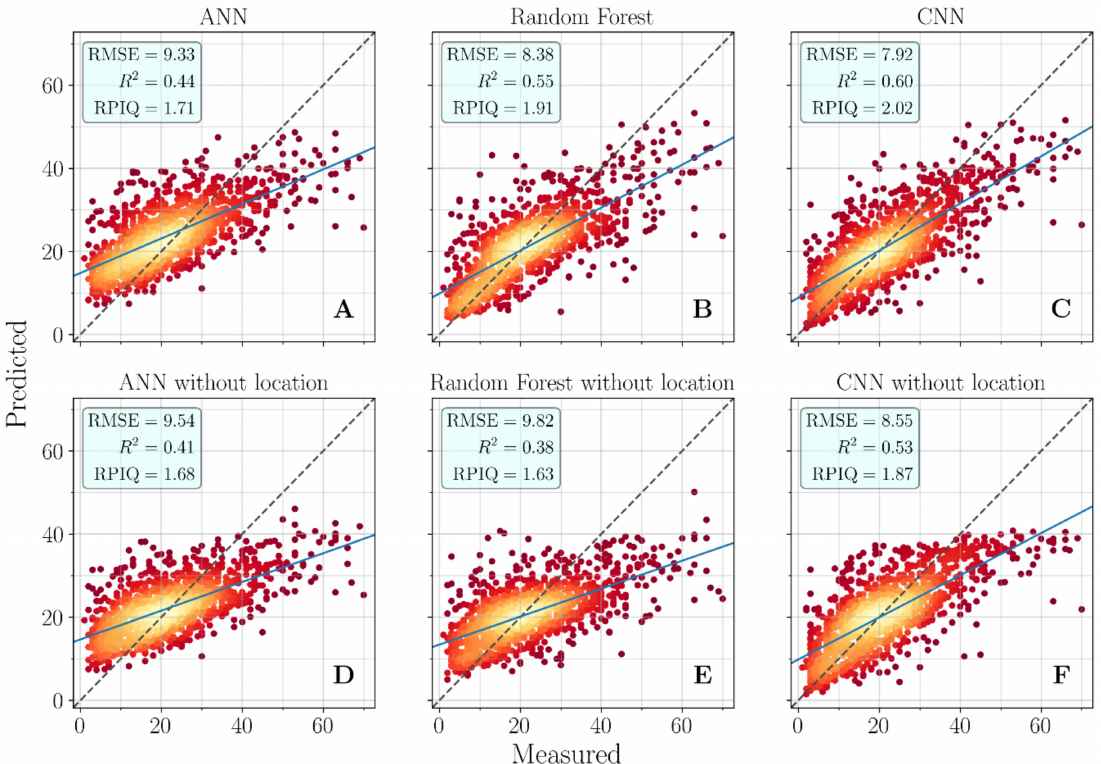
Figure 9. Goodness of fit indicating the relationship between observed and predicted clay content of the artificial neural network (ANN; A ) and random forest (RF; B ) models using as inputs the median synthetic reflectance values and the geographical coordinates; and the proposed CNN ( C ) model using both optical and radar values conjoint with the auxiliary input of geographical coordinates; the aforementioned ANN ( D ), RF ( E ), and CNN ( F ) models without the conjoint used of the geographical